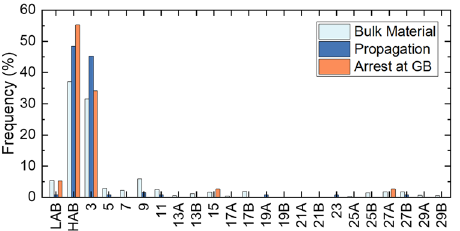
Fig. 6 The GB type and CSL boundaries distribution of the bulk material, crack propagation, and arrest scenarios along the 37 crack paths.